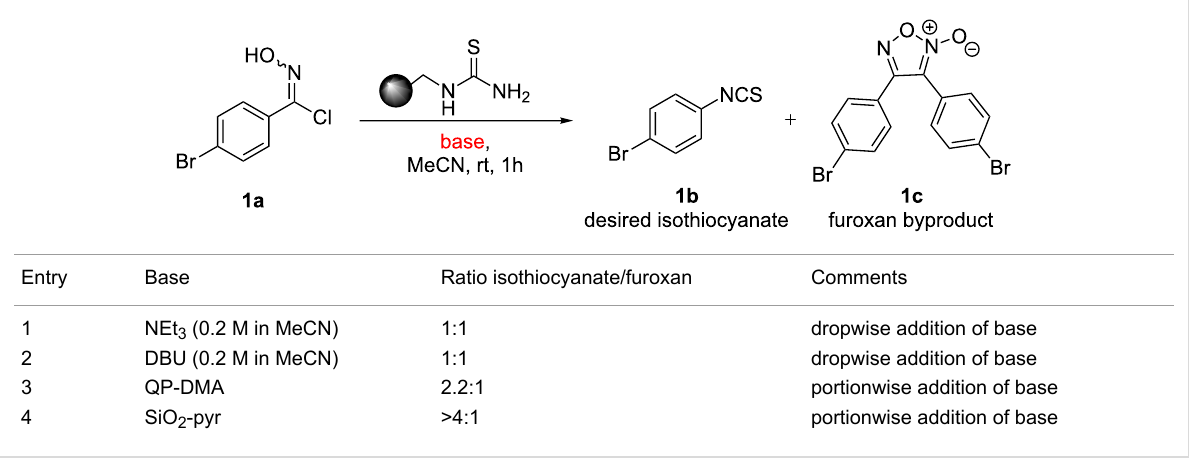
Table 1: Screening of different bases for the formation and conversion of nitrile oxides in batch: